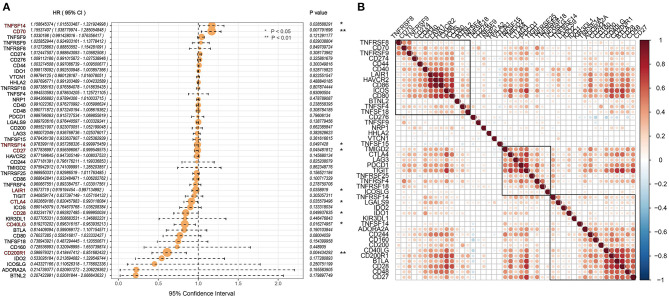
(A) Relationship between ICGs expression and prognosis in forest plot. Abscissa represents 95% confidence interval, ordinate (left) represents gene, and the vertical line in the middle of P-value represents the invalid line. When the horizontal line of 95% confidence interval of a gene crosses with the invalid line, it can be considered that there is no statistical correlation between gene expression and patient survival. If the horizontal line falls to the left of the invalid line, the gene can indicate a higher likelihood of success for patient prognosis. If the horizontal line falls to the right of the invalid line, it can be considered as a risk factor for the patient survival. (B) Correlation heatmap of ICGs expression levels. Only the gene pairs with significant correlation test are shown: the blank indicates zero significance of correlation test, blue represents negative correlation, and red represents positive correlation. *P < 0.05, **P < 0.01.